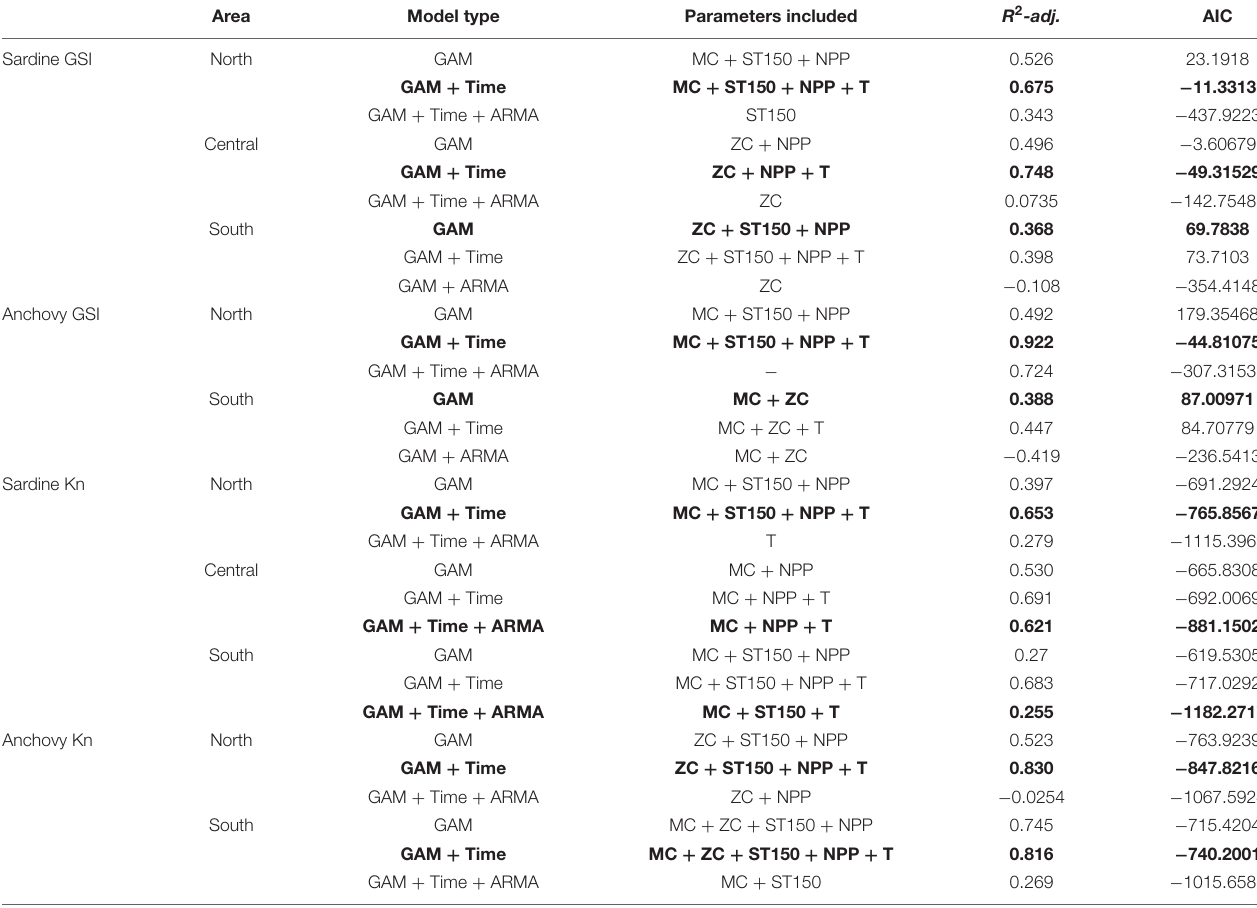
TABLE 1 | Comparison between the Generalized Additive Model selected (GAM) of GSI and Kn, the GAM combined with the temporal explanatory variable (time variable) (GAM + Time) and the GAM combined with an ARMA model (corARMA), for each species (sardine and anchovy), trait (GSI and Kn) and for each area.